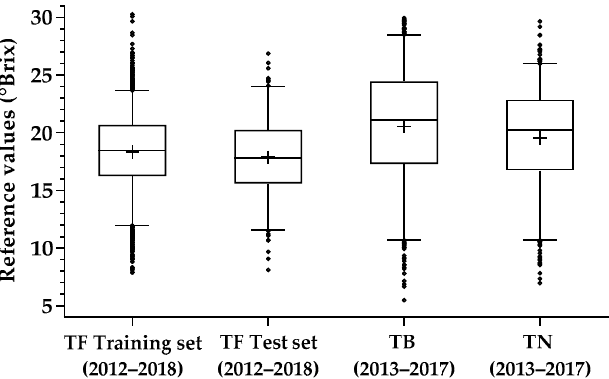
Figure A1. Boxplot of the descriptive statistics for sugar content reference values used for training process and independent test sets. The box represents the 25th, 50th and 75th percentiles, the whiskers the 5th and 95th percentiles, the lower and upper open circle the minimum and maximum values and the plus symbol the mean values.